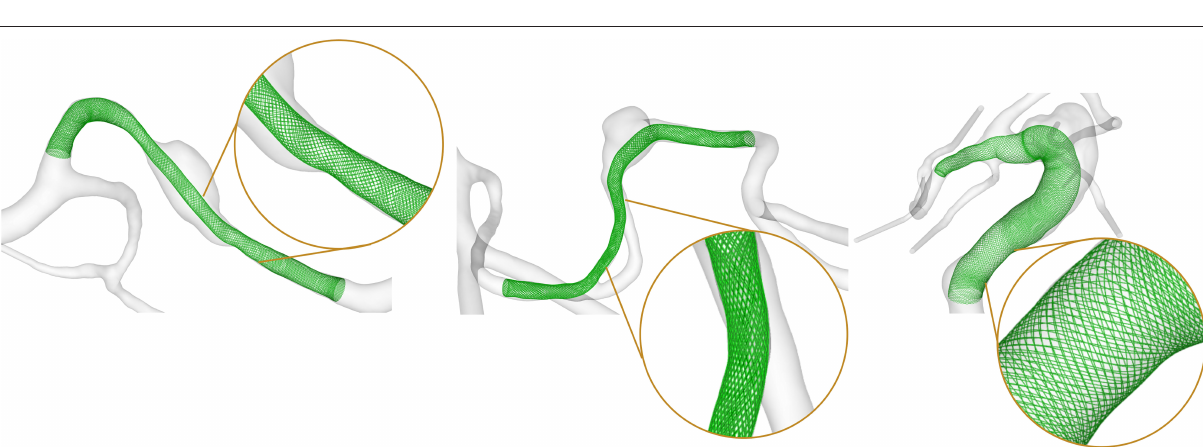
FIGURE 1 | Depiction of the three fusiform aneurysm cases (marked with an arrow) and their corresponding healthy 3D models. Case 1 is depicted in (A,B) . Case 2 is depicted in (C,D) and Case 3 is depicted in (E,F) , respectively. Furthermore, for each fusiform aneurysm case, a detailed presentation is given in (G–I) .